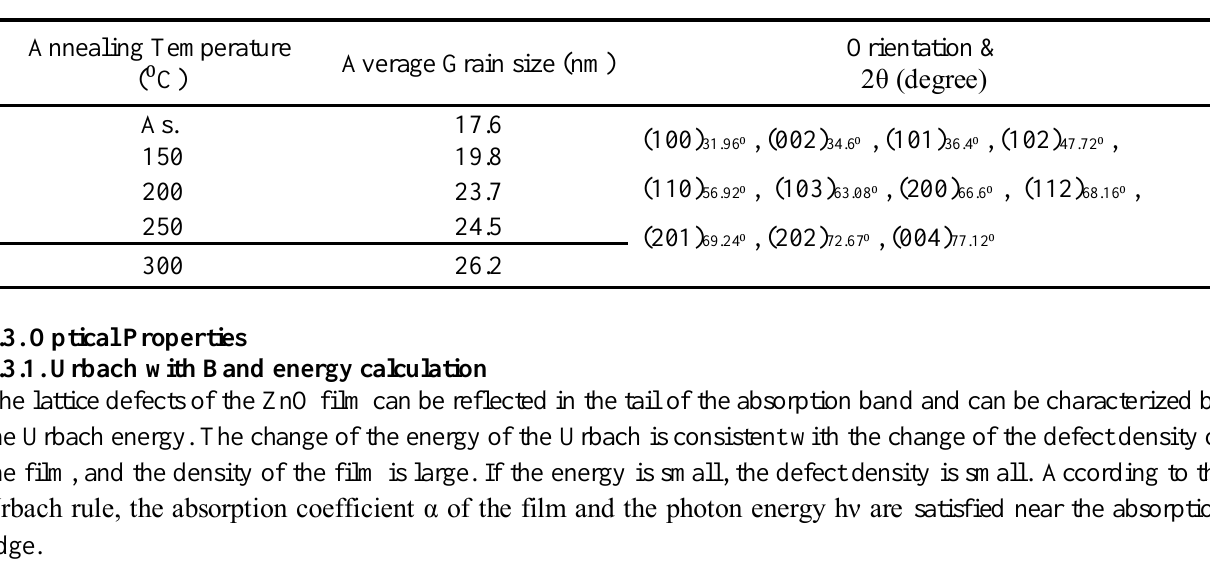
Figure 5: X-ray diffraction spectrum of the ZnO thin film before and after treatment by the OTA technique Table 1 lists the ZnO film treatment by the OTA technique at temperatures 150 200 250 300. Diffraction peak angle position, crystal plane distance, full width at half maximum, and stress. The film sample has a certain shift from the peak position to the high diffraction intensity compared with the peak position of the As-deposited sample. As the working pressure increases, the offset angle increases, and the inter-planar spacing changes. It can be seen that the ZnO thin film has a certain shift from the peak position to the high diffraction intensity compared with the other peak of the As-deposited sample, and as the annealing temperature increases, the offset angle increases, and the inter-planar spacing changes. The peak position shift of the film sample indicates that the film has internal stress, which causes the crystal lattice to be stretched or compressed. According to the film property formula, the film stress can be calculated by measuring the crystal lattice distortion, which agrees with [10]. Table 1. Relationship between microstructure parameters and deposition pressure of ZnO thin